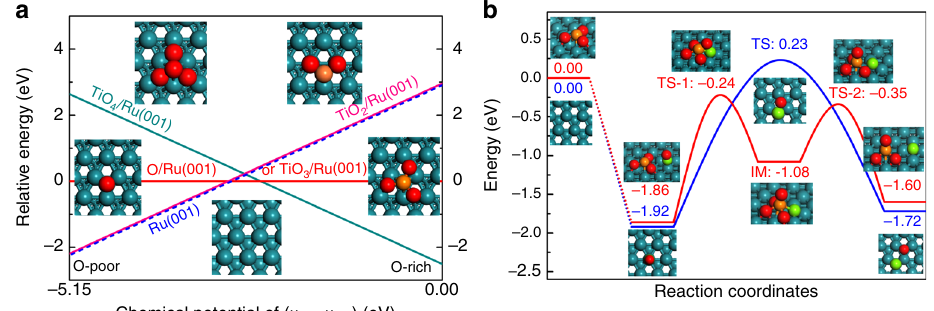
Fig. 5 Theoretical study of the CO activation on a TiO x cluster decorated Ru(001) surface. a Thermodynamic stability of different TiO x /Ru(001) and O/Ru(001) under a variation of the chemical potential of O as referring to TiO 3 /Ru(001) and Ru(001), respectively, with the atomic con fi guration in insets. Atom key: Ru (dark blue), O (red), Ti (orange), and C (green). b A possible catalytic mechanism of CO activation at GW level calculations on the TiO 3 /Ru (001) model surface (red line), with the dissociation of CO on Ru(001) surface as a comparison (blue